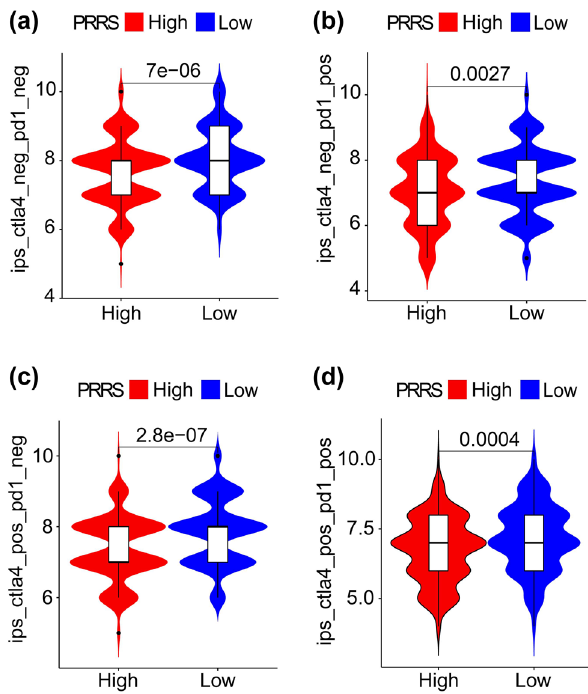
Figure 7: Guidance of PRRS in LUAD immunotherapy. ( a – d ) LUAD patients in the L - PRRS will bene fi t more from CTLA4 and, or PD1 inhibitor